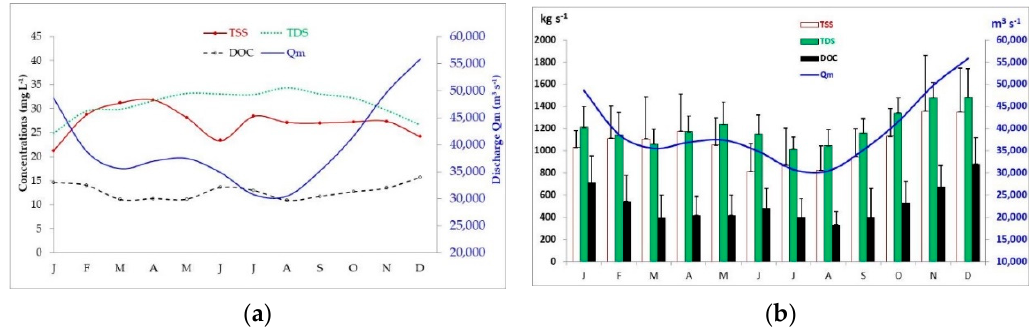
Figure 14. ( a ) Mean monthly discharge (Q), Total Suspended ‐ Sediment (TSS), Total Dissolved Solid (TDS) and Dissolved Organic Carbon (DOC) concentrations and their ( b ) fluxes of the Congo River at Brazzaville (for the period 2006–2017) [56].